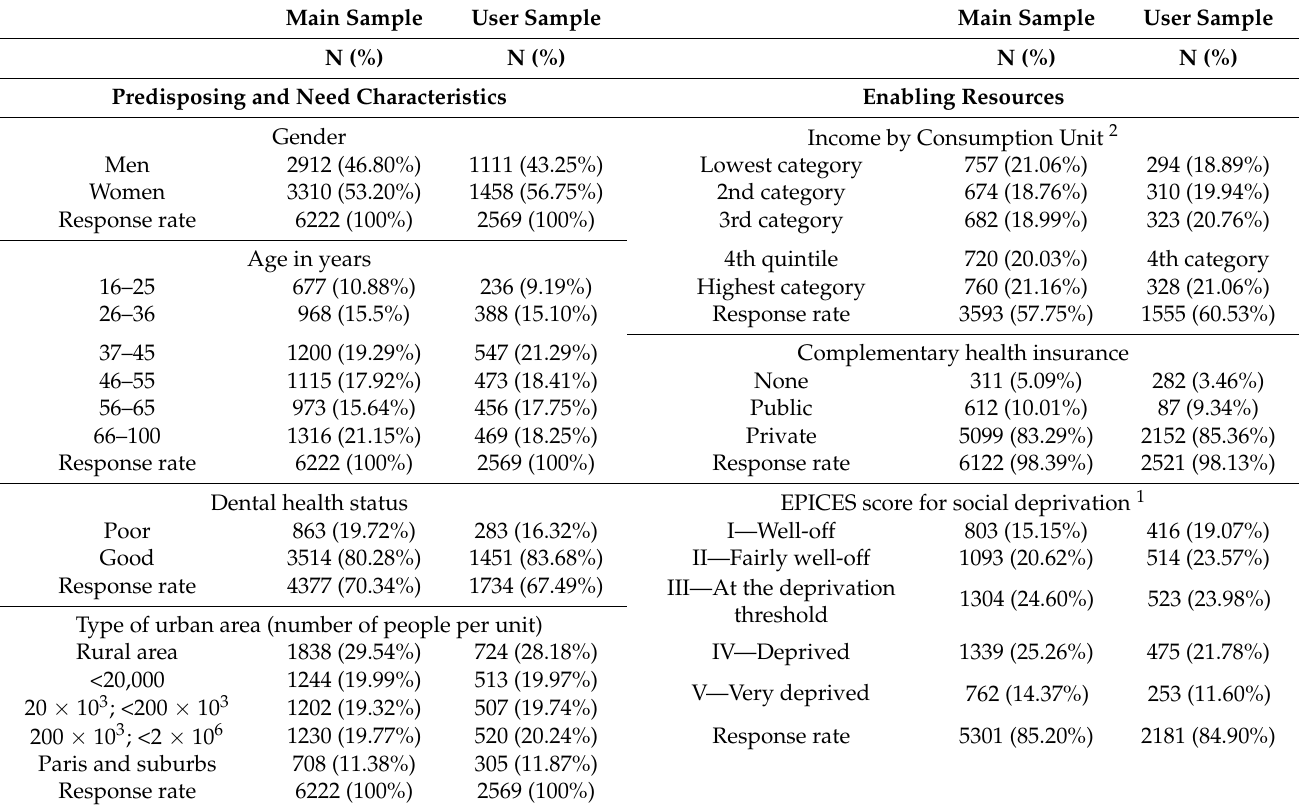
Table 1. Descriptive statistics of the explanatory variables for the main sample (N = 6222) and the service user sample (N =